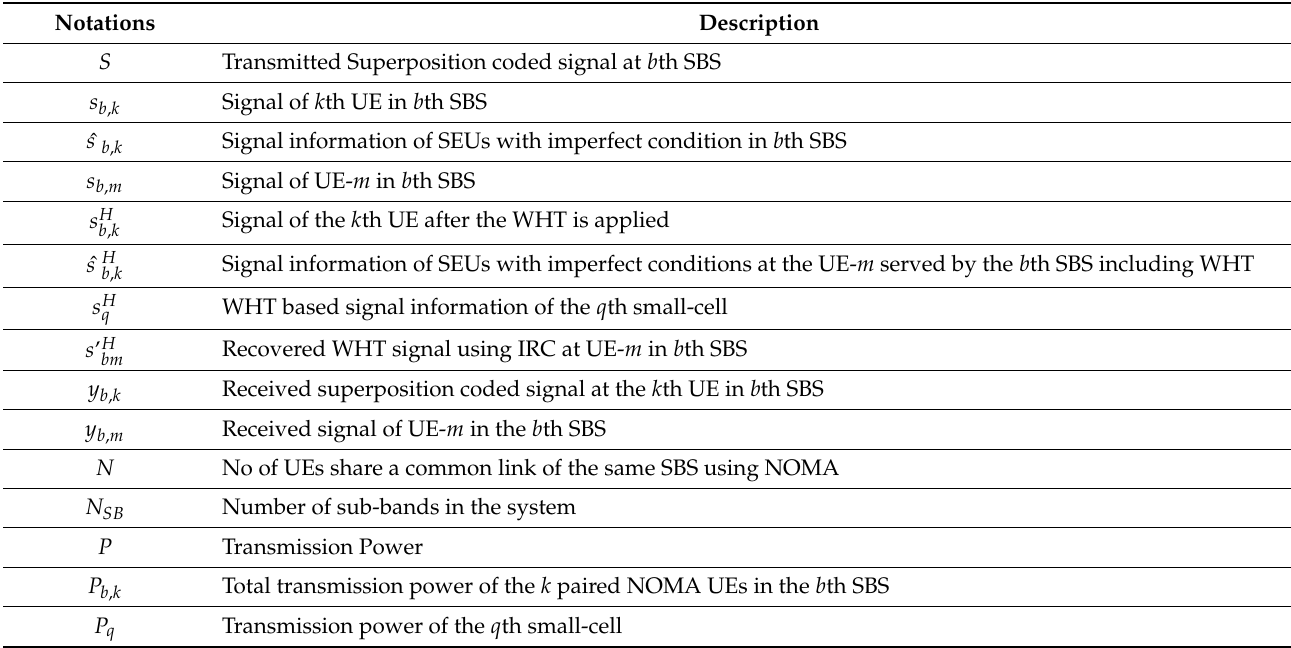
Figure 4. Transceiver block diagram for WHT with joint NOMA and IRC. Table 1.